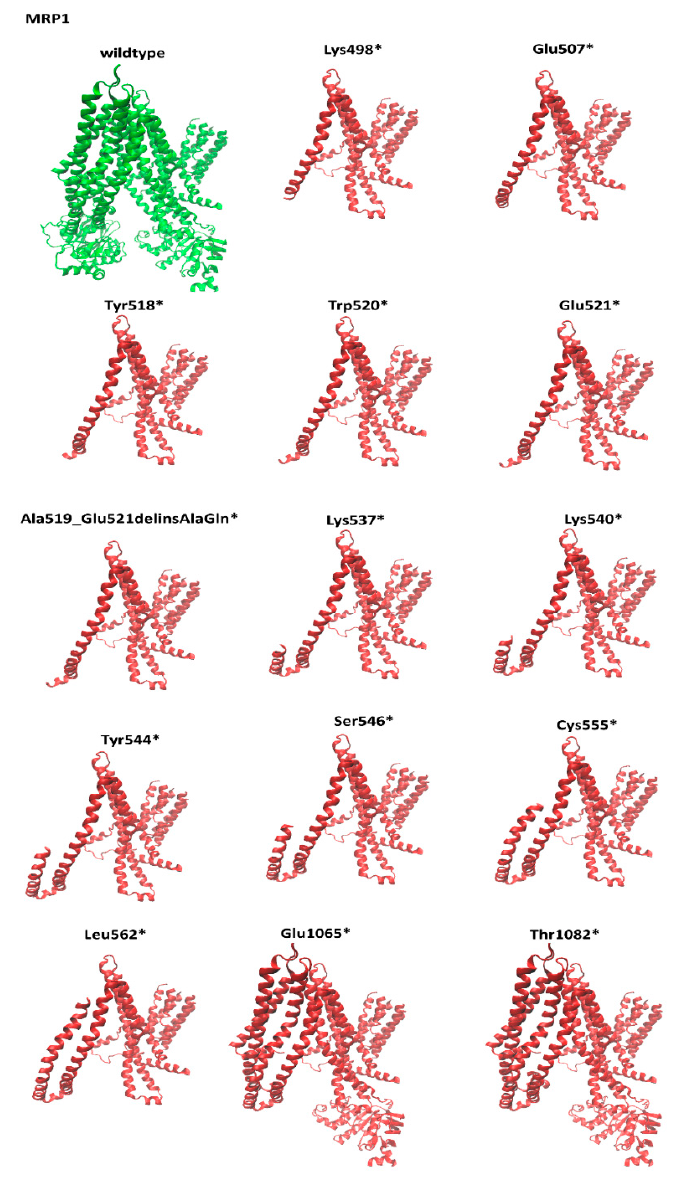
Figure 2. Influence of nonsense mutations on the ABCC1 gene and structural comparison with wild-type MRP1 protein structure. Wild-type MRP1 protein (green) and mutant MRP1 homology models (red).